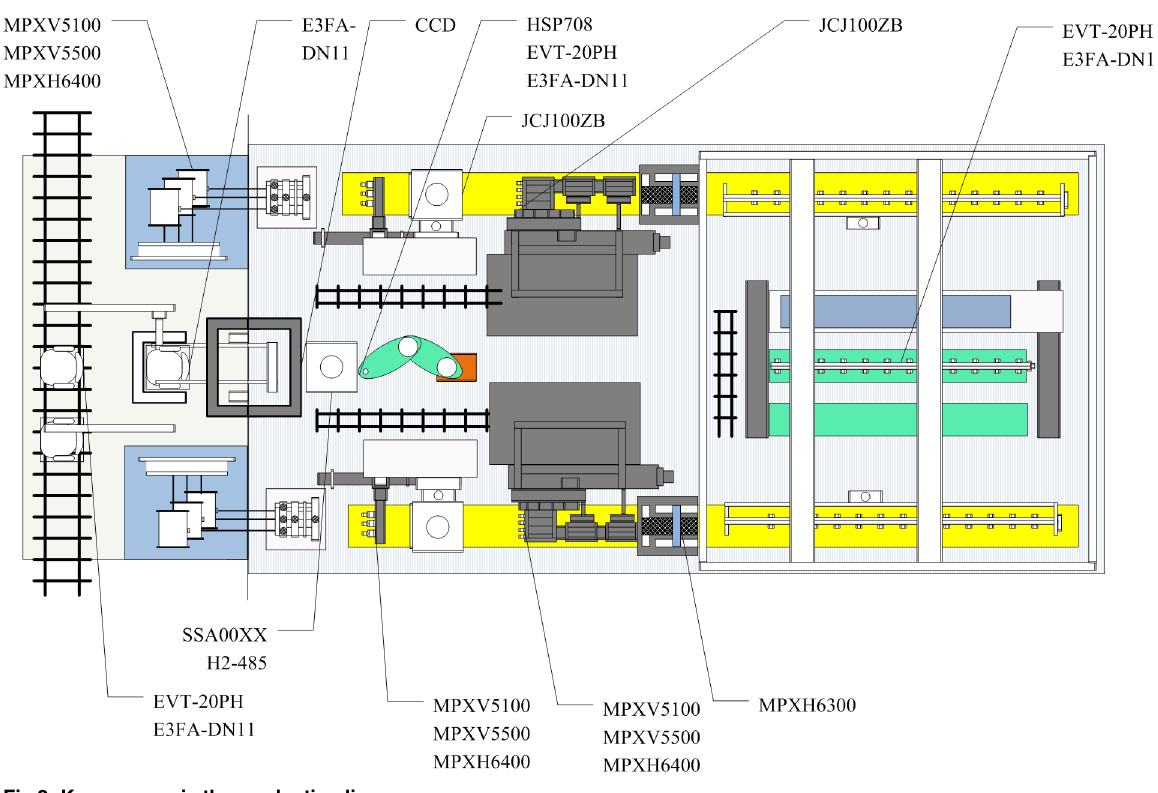
Fig 2. Key sensors in the production line.